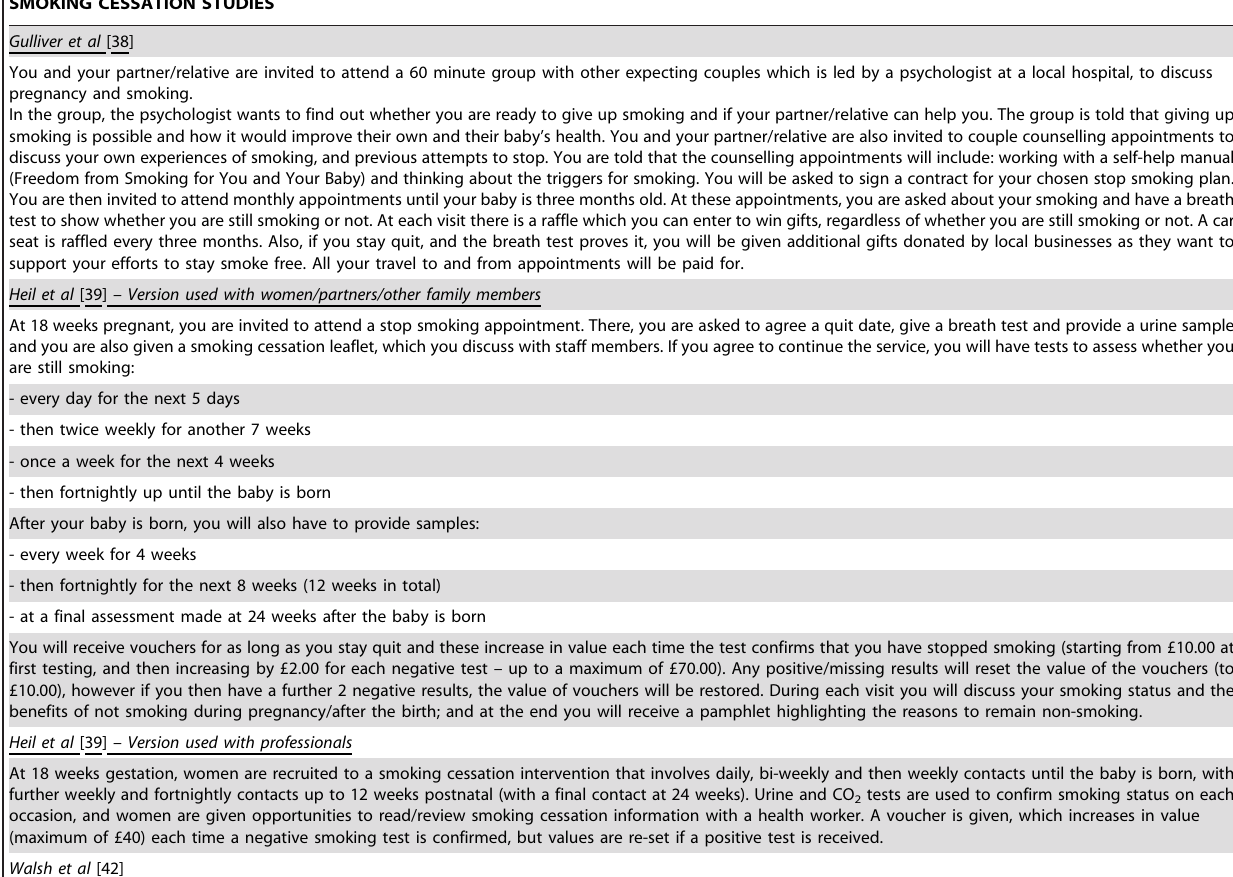
Table 2. Intervention